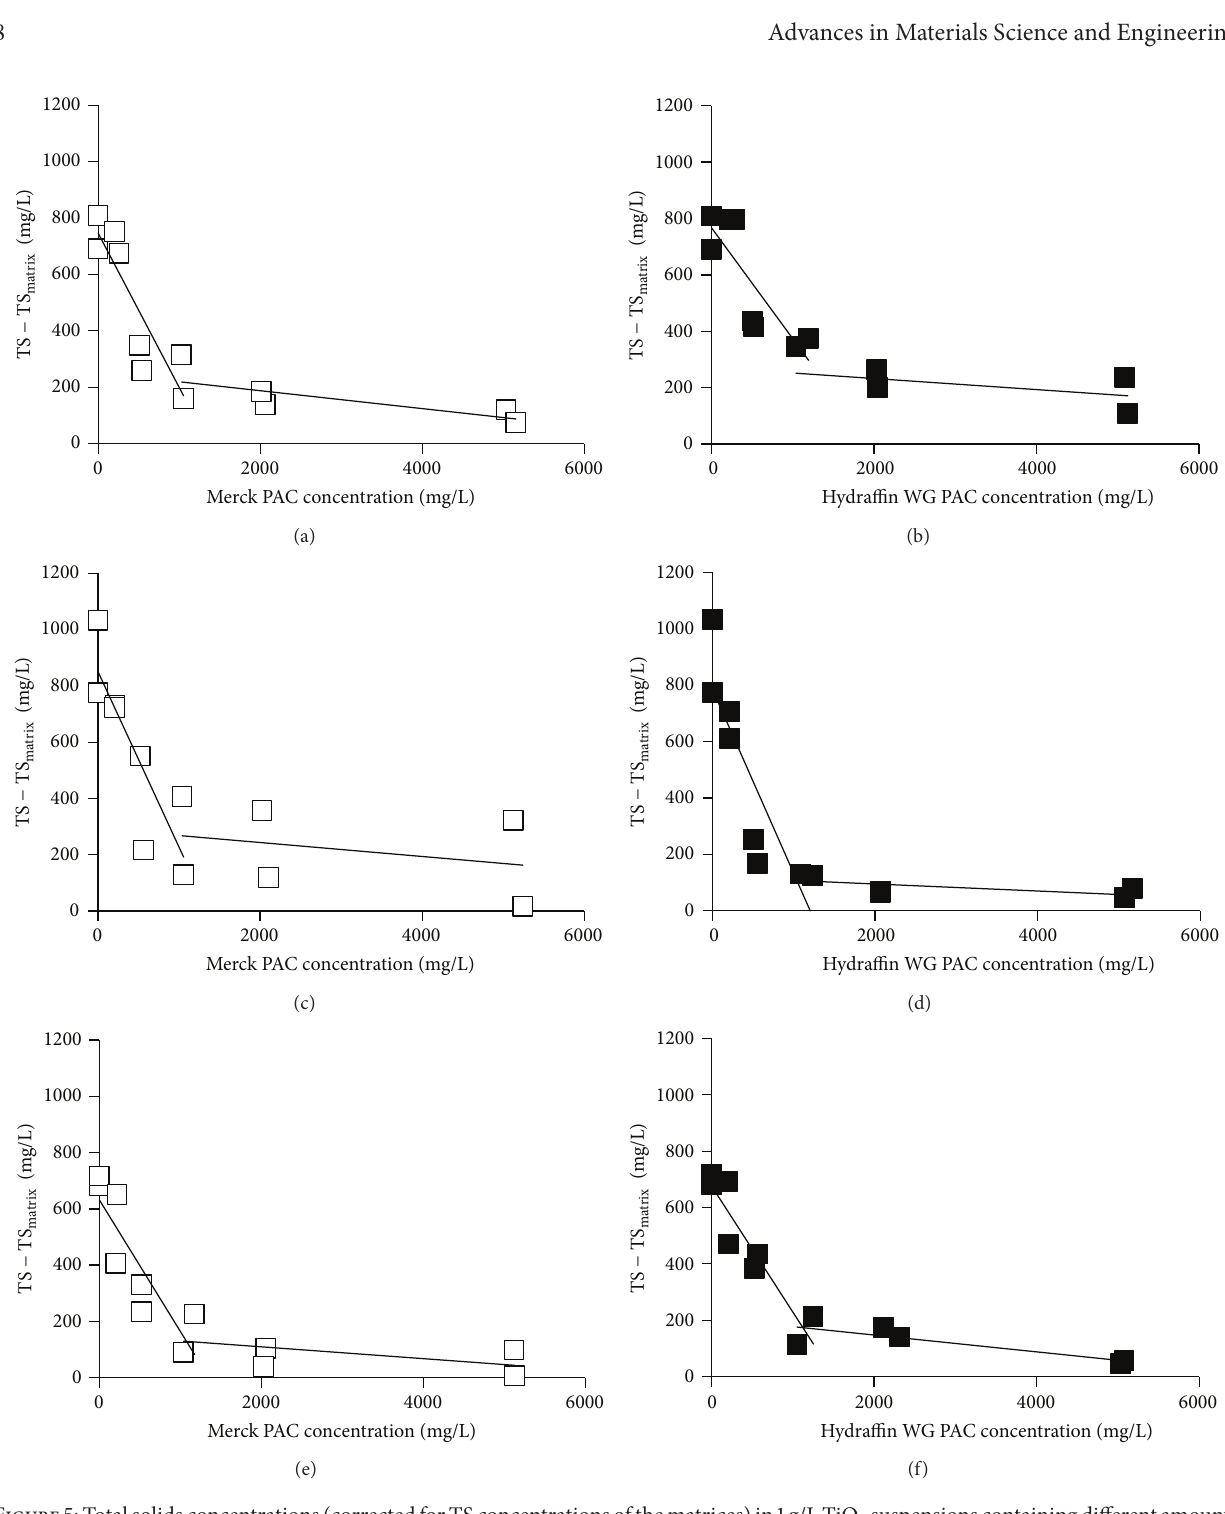
Figure5:Totalsolidsconcentrations(correctedforTSconcentrationsofthematrices)in1 g/LTiO 2 suspensionscontainingdifferentamounts of Merck PAC or Hydraffin WG PAC in different matrices ((a), (b): 0.1 g/L NaHCO 3 solution; (c), (d): 0.5 g/L NaHCO 3 solution; (e), (f): 1g/L NaHCO 3 solution) subsequent to vacuum filtration over spunbond polypropylene